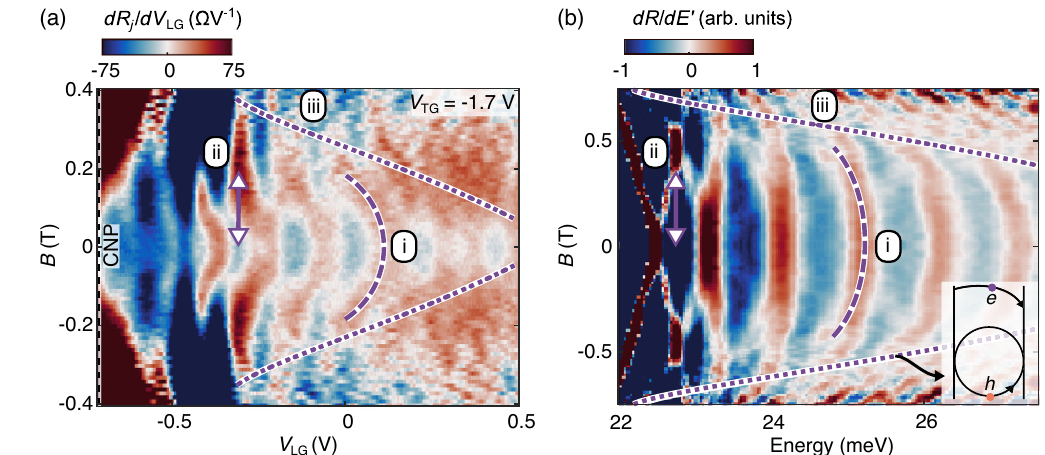
− 1 . 7 V and 1.3 K. as a function of V and B at V LG LG TG ¼